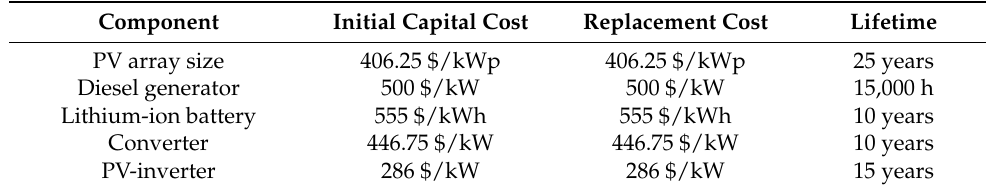
Table 4. Mini-grid component cost data